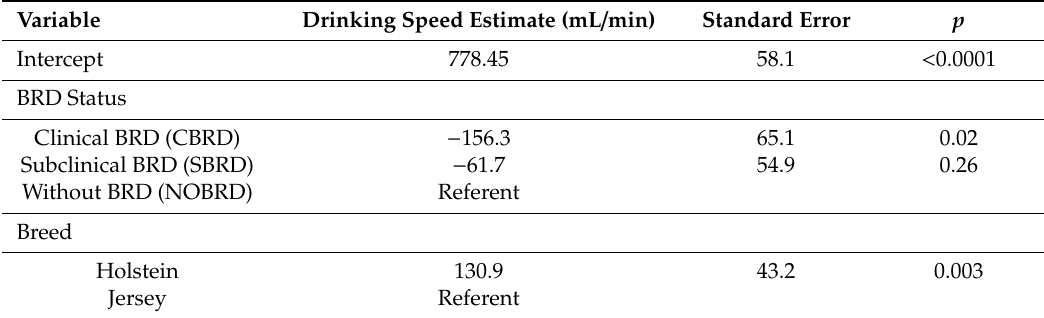
Table 3. Multivariable linear regression model for drinking speed (mL / min) collected from an automated milk feeder in 103 preweaned dairy calves. Calves were enrolled in the study at 21 ± 6 (mean ± SD) d of age and underwent twice weekly health exams. The primary predictor of interest was Bovine Respiratory Disease (BRD) status. Drinking speed was analyzed for 3 d prior to, the d of, and 3 days after BRD detection. Estimates for drinking speed and reported p are from solutions for fixed e ff